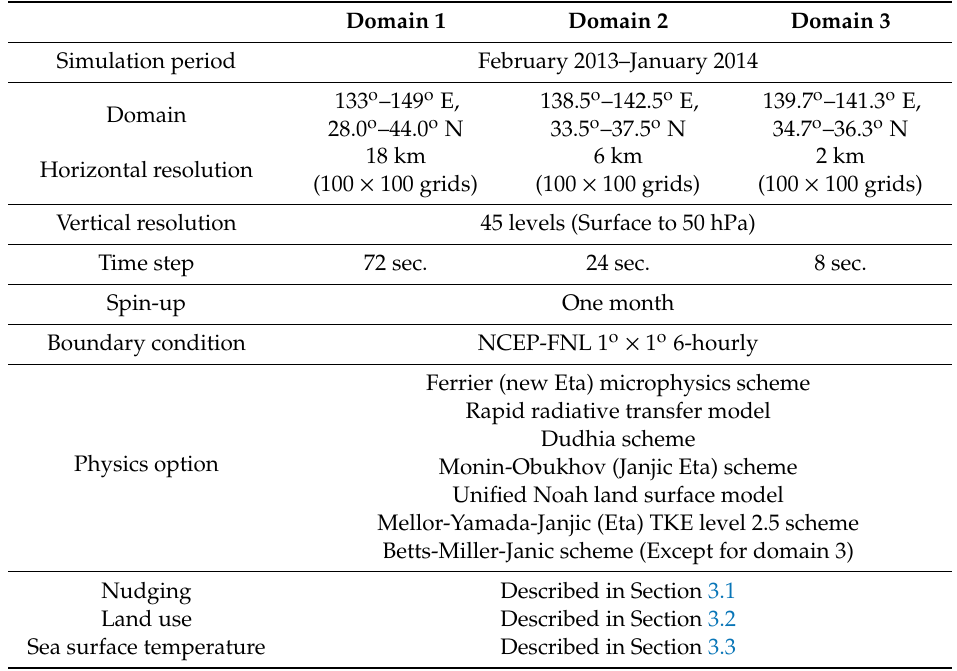
Table 1. Description of the mesoscale model and computational